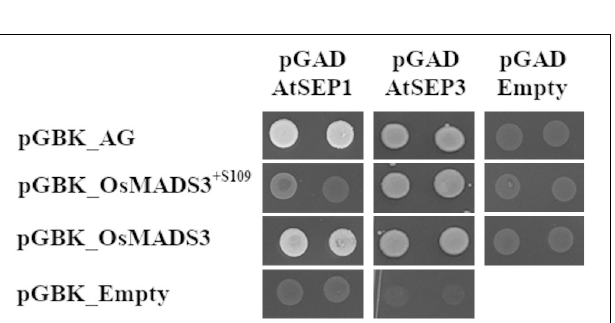
FIGURE 7 | Yeast-2-hybrid interaction assay for AtAG, OsMADS3 + S 109 , OsMADS3, AtSEP1 and AtSEP3, interactions on -W-L-H + 5 mM 3AT are shown. AtAG and OsMADS3 are able to interact with both AtSEP1 and AtSEP3, while OsMADS3 + S 109 can interact only with AtSEP3. As a positive control, the already published AtAG-AtSEP3 interaction was tested and, as a negative control, the vectors of interest were co-transformed with the empty pGAD or pGBK